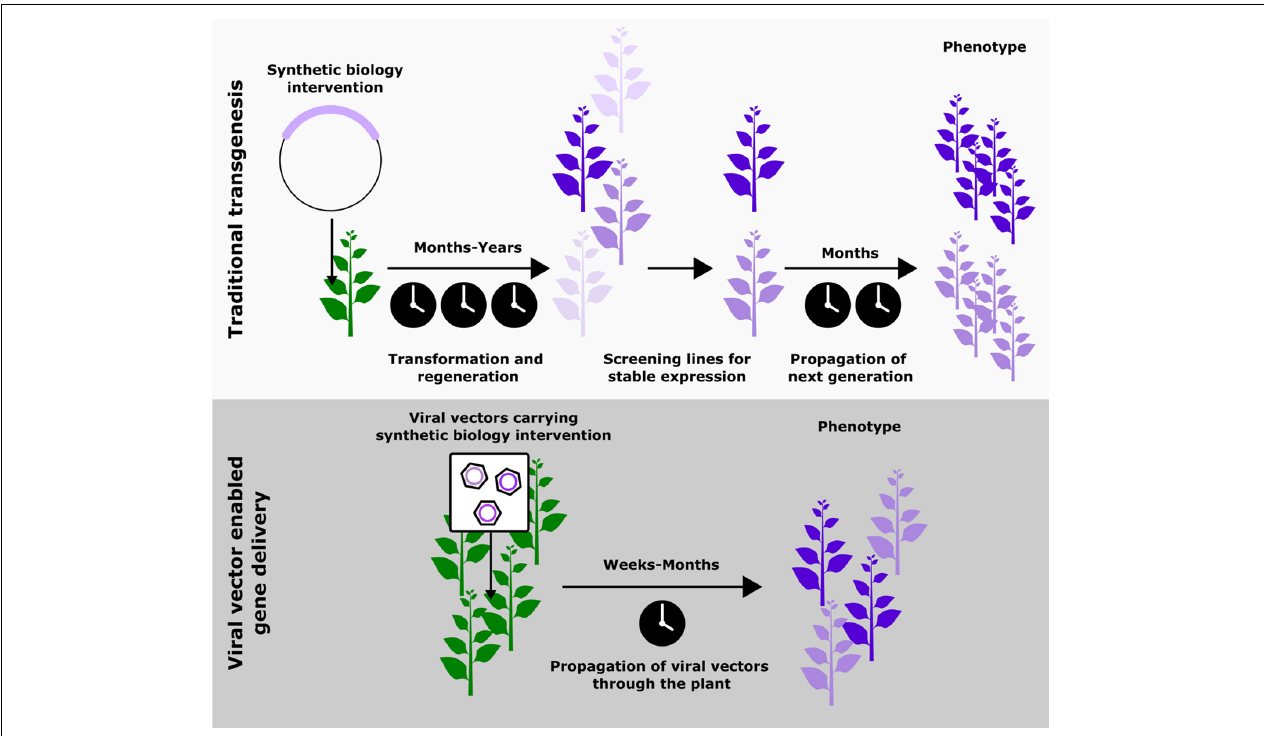
FIGURE 1 | Schematic comparing the steps and approximate timescales associated with traditional transgenesis and viral vector mediated gene delivery as a means to implement synthetic biology-based modifications in plants. The top panel is adapted from Khakhar et al. (2021). Copyright American Society of Plant Biologists;